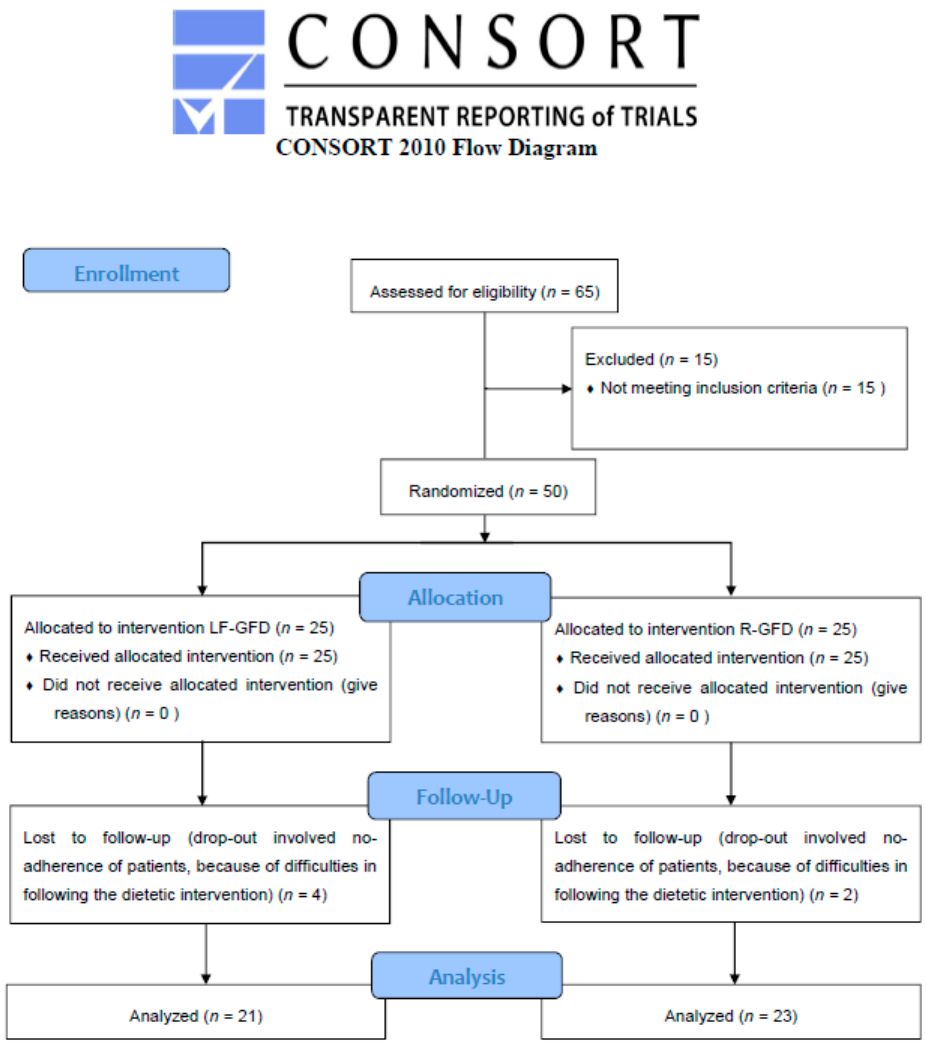
Figure A1. CONSORT Flow diagram.